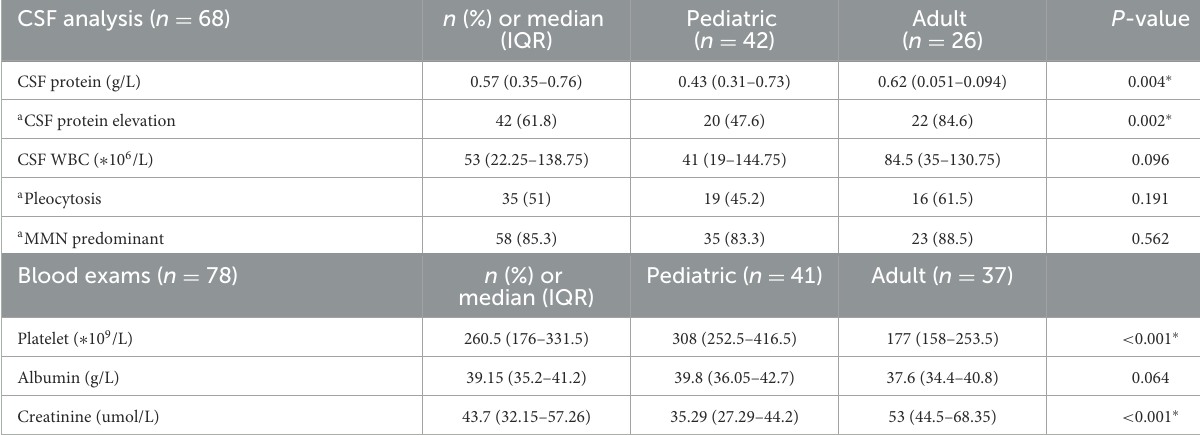
TABLE 3 Summary of laboratory findings of pediatric and adult patients with JE.